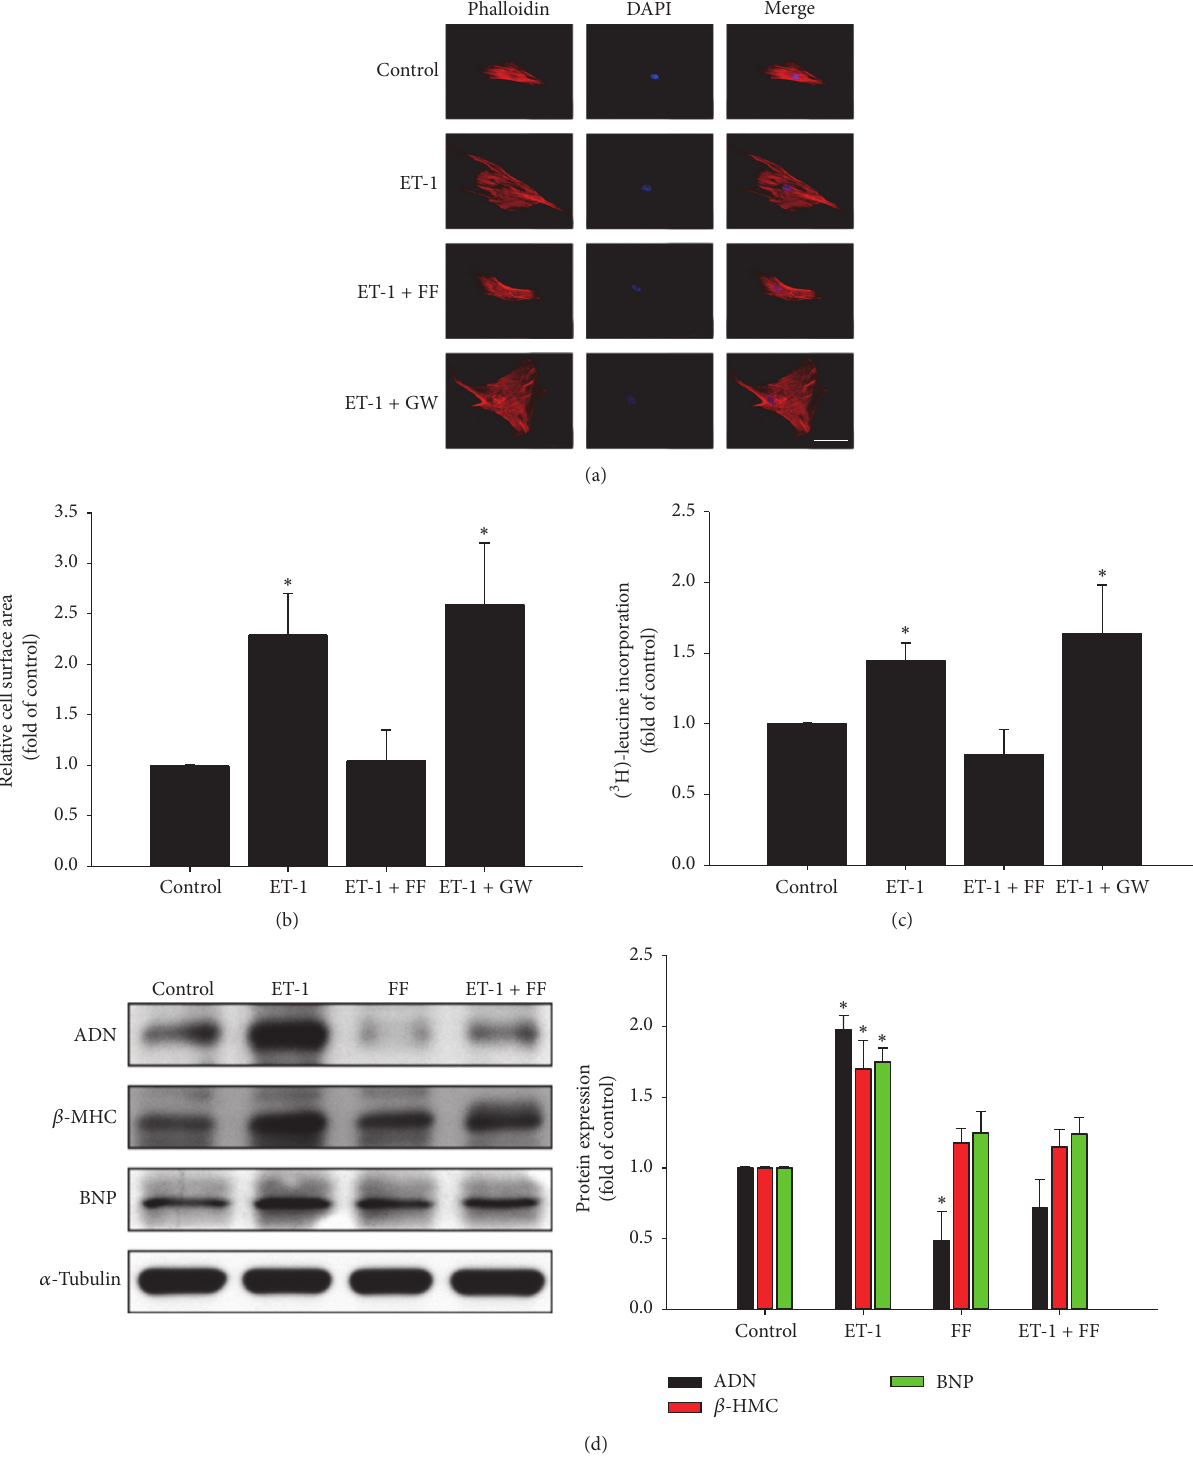
Figure 1: Fenofibrate inhibited ET-1-dependent hypertrophy and adiponectin expression. The role of fenofibrate and ET-1 in human cardiomyocyte cell size was assayed by pretreatment of cells with PPAR 𝛼 agonist (fenofibrate; FF) or PPAR 𝛼 antagonist (GW6471; GW) for 24 h, followed by stimulation with or without ET-1 (50nM) for 48h. Cells were fixed and stained with rhodamine-phalloidin (red) and DAPI (blue) followed by cell surface area quantization (scale bar, 50 𝜇 m) (a). Data are expressed as mean ± SEM of values from three